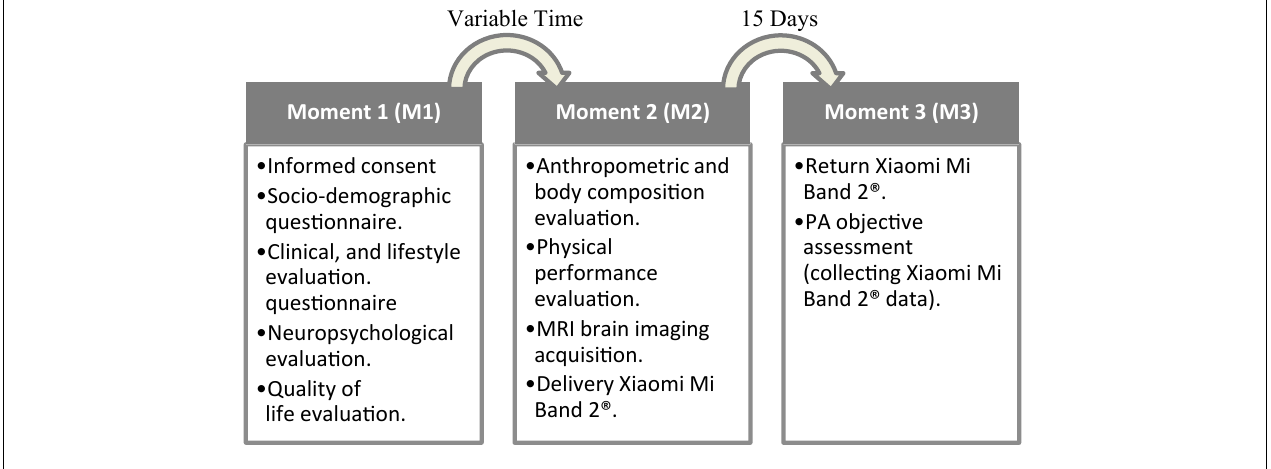
FIGURE 1 | Flow diagram of the evaluation